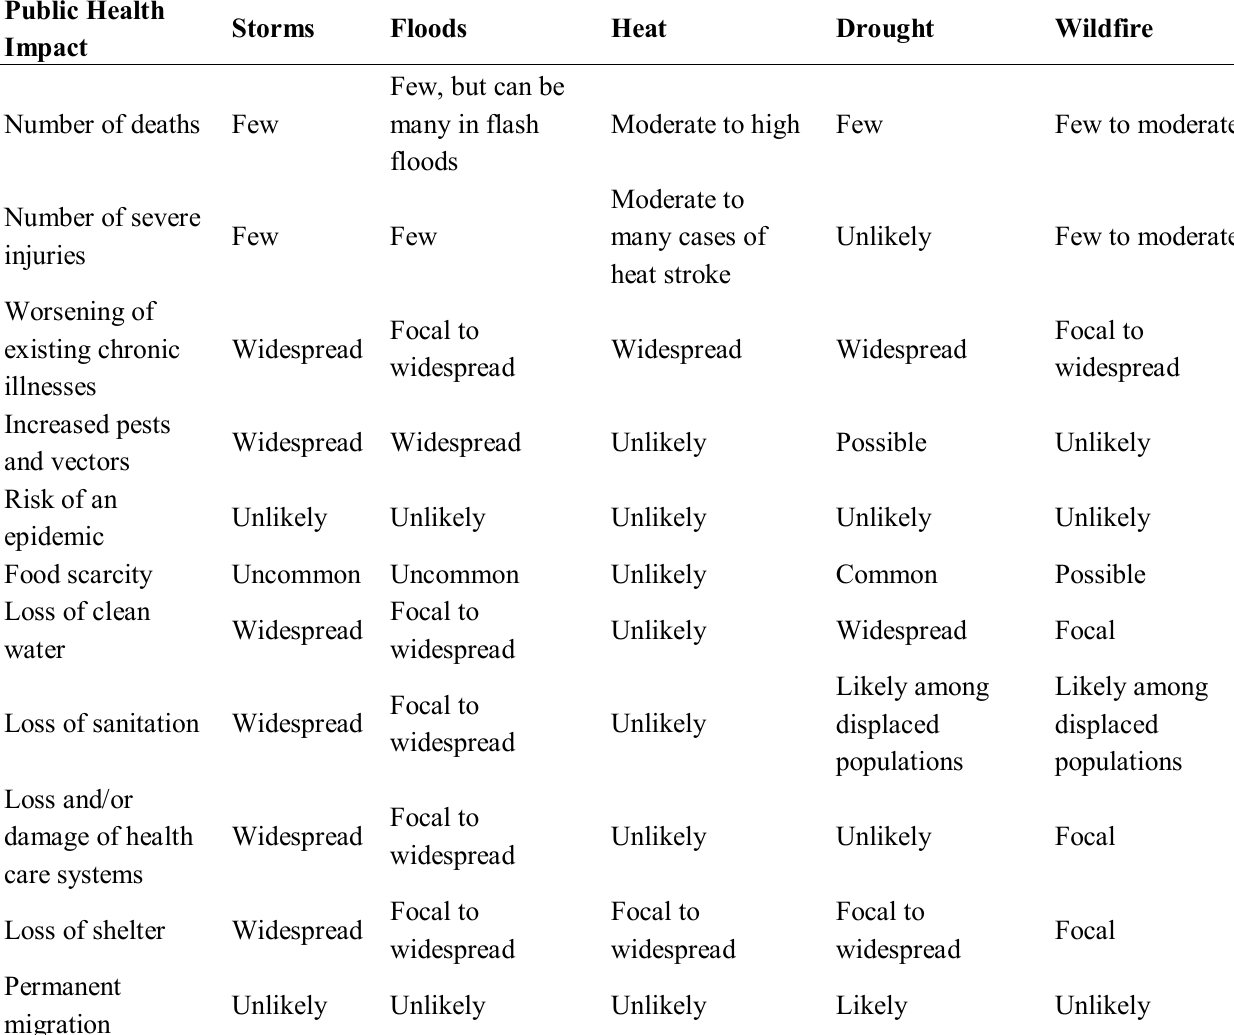
Table 1. Relative public health impacts of selected extreme weather events. Source: Modified from